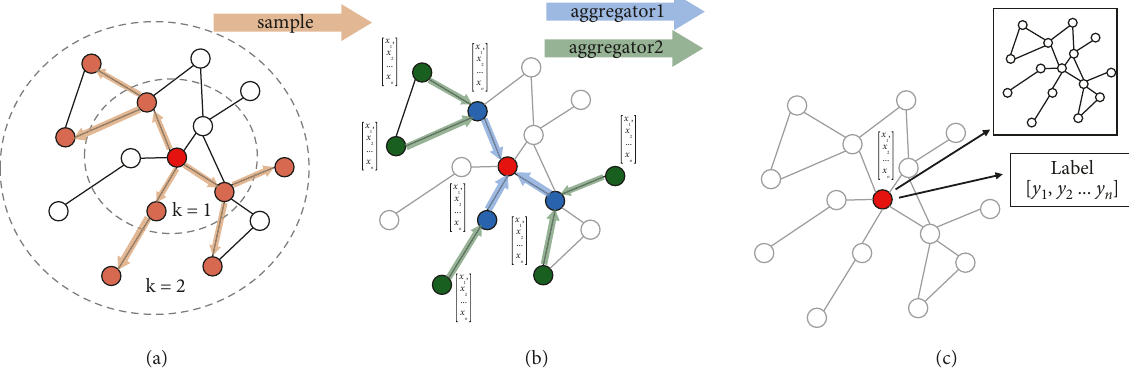
Figure 3: The process of feature extraction based on GraphSAGE(25). (a) Sample neighborhood, (b) Aggregate feature information from neighbors, (c) Predict graph context and label using aggregated information.